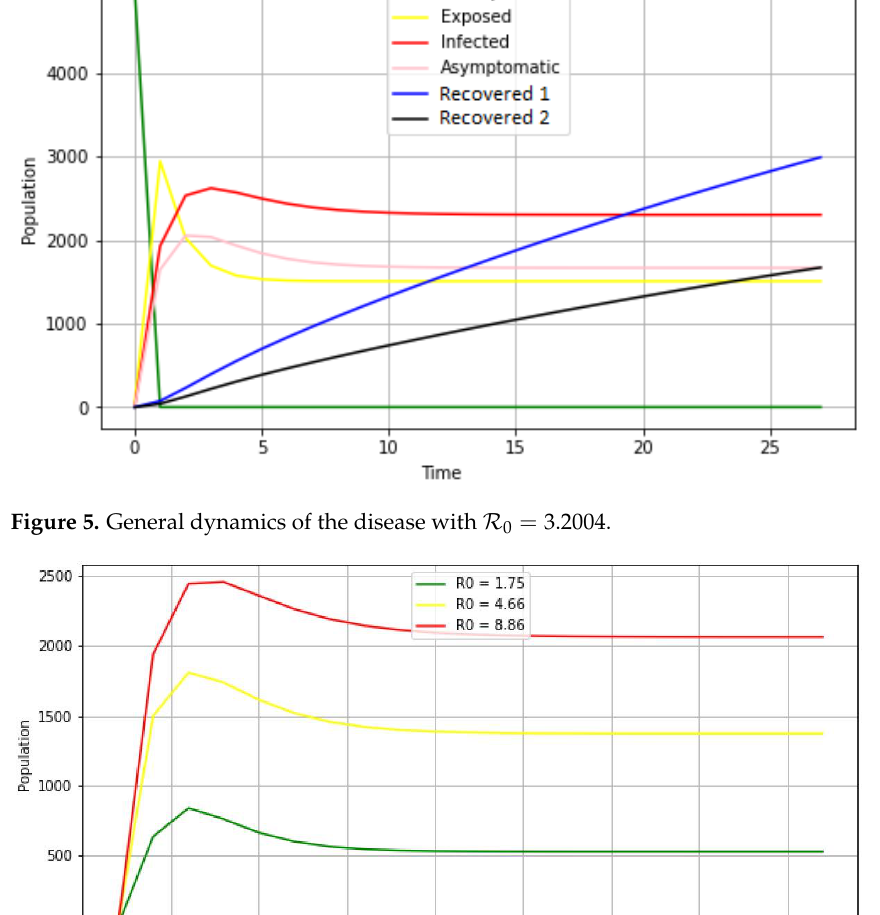
. Figure 6. Illustration of the progression of the infected individuals according to the R 0 R 0